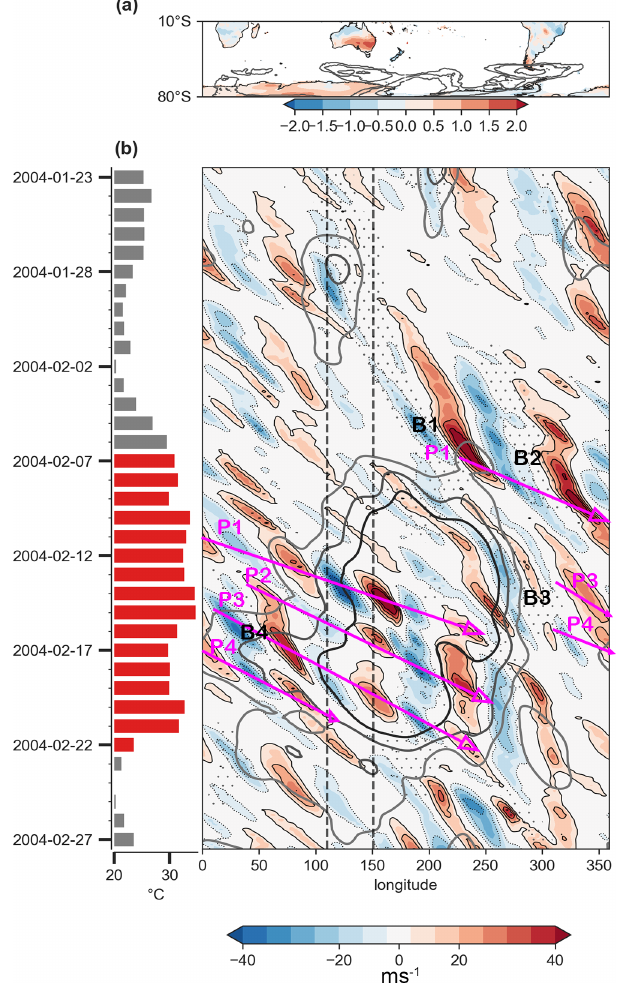
Figure 4. RRWPs and blocks during the 2004 SEA heatwave. (a) Filled contours depict the time mean of the standardized day-of- year anomalies of daily-maximum T2m over land for the duration of the heatwave. Contours show the mean blocking frequency during the heatwave (5%, 10%, 20%). (b) Bars show daily-maximum 2m temperature averaged over SEA ( ◦ C); red marks the heatwave pe- riod. The Hovmöller diagram shows the meridional wind at 250hPa averaged between 35 and 65 ◦ S (filled contours; ms − 1 ), R values (grey contours; 6, 8, 10ms − 1 ), and longitudes at which at least one grid point between 40 and 70 ◦ S featured an atmospheric block (stippling). Rossby wave packets (blocks) are labelled in magenta